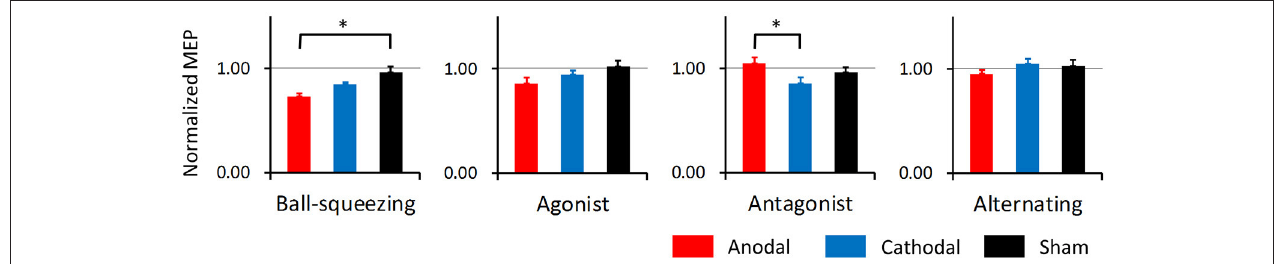
FIGURE 3 | Normalized MEP amplitudes pooled across 60 min after intervention. Based on the time course shown in Figure 2 , normalized MEP amplitudes were pooled for the 60 min in each participant and averaged for each task and polarity. As in Figure 1 , red bars indicate anodal, blue cathodal, and black sham tDCS. Error bars represent standard errors of the mean. Asterisks denote significant simple main effects in pair-wise